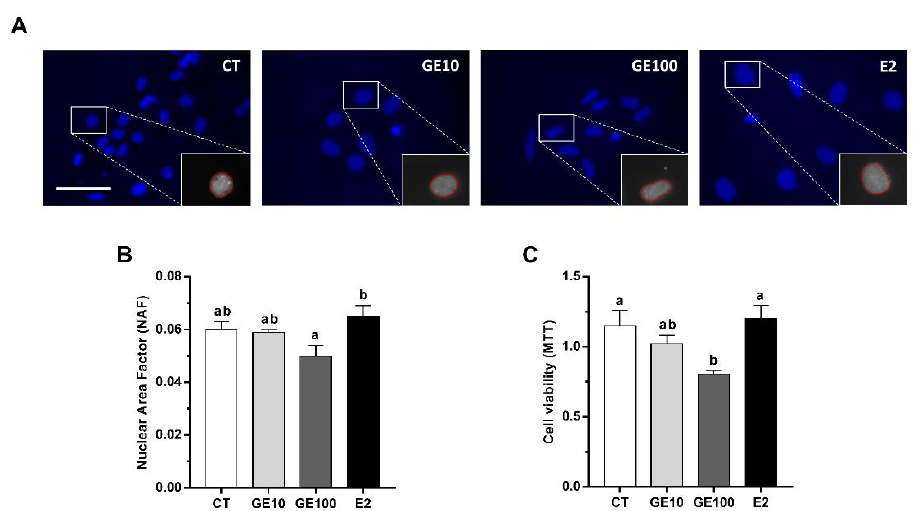
Figure 1. In vitro effects on pre-confluent rainbow trout preadipocytes incubated at day 5 of culture for 24 h with GE at different concentrations (10 and 100 μM), E2 (1 μM), or vehicle (0.1% DMSO) as CT. ( A ) Representative immunofluorescence images stained with Hoechst for nuclei and ( B ) quantification of the nuclear area factor (NAF). ( C ) Quantification of cell viability using a methylthiazolyldiphenyl-tetrazolium bromide (MTT) assay. Scale bar 100 μm. Data are shown as mean + SEM ( n = 4–6). Significant differences among treatments were determined by one-way ANOVA and are indicated by different letters ( p < 0.05). When two groups share at least one letter, they are not statistically different. CT: Control; GE: Genistein; E2: 17β-estradiol.